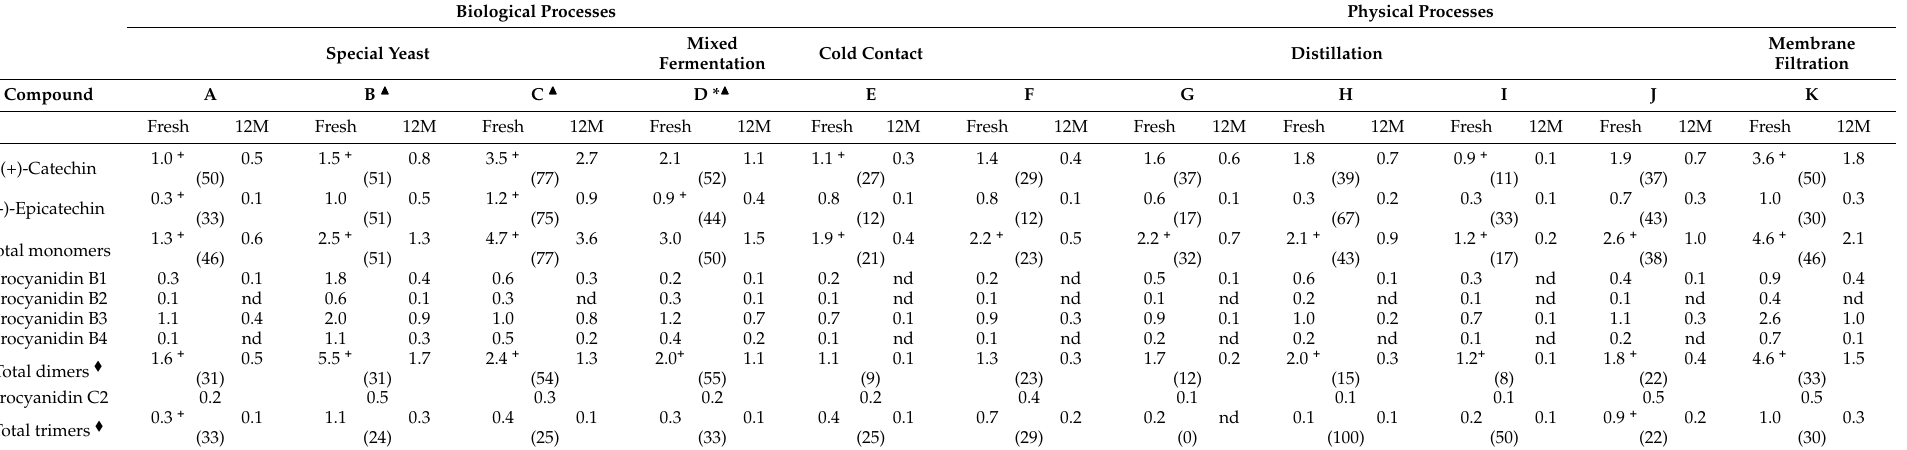
Table 1. Concentrations (mg/L) of (+)-catechin; (-)-epicatechin; dimers B1, B2, B3, and B4; total dimers (S/N > 9); trimer C2; and total trimers (S/N > 9) in the 11 fresh and aged (12M) investigated NABLABs. Values in parentheses indicate remaining percentages after one year of storage at 20 ◦ C in the